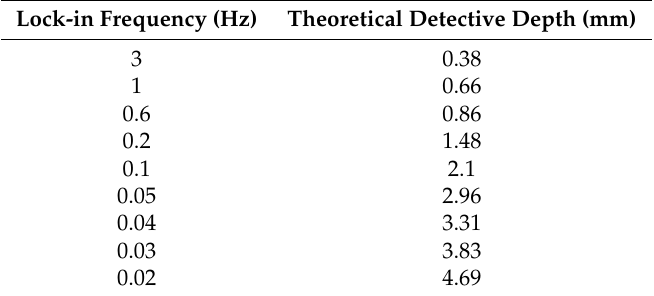
Table 1. Theoretical